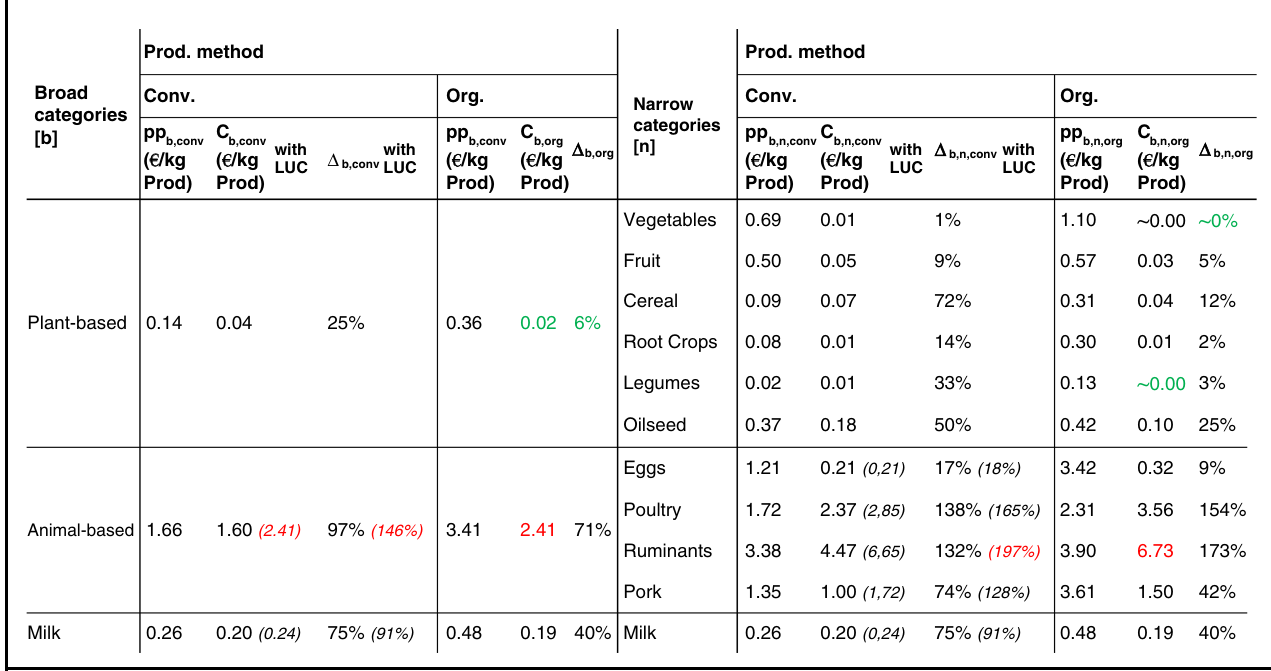
Table 3 Producer prices (pp), external costs (C) and percentage price increases ( Δ ) for narrow and broad food categories when externalities resulting from greenhouse gas emissions are monetized.